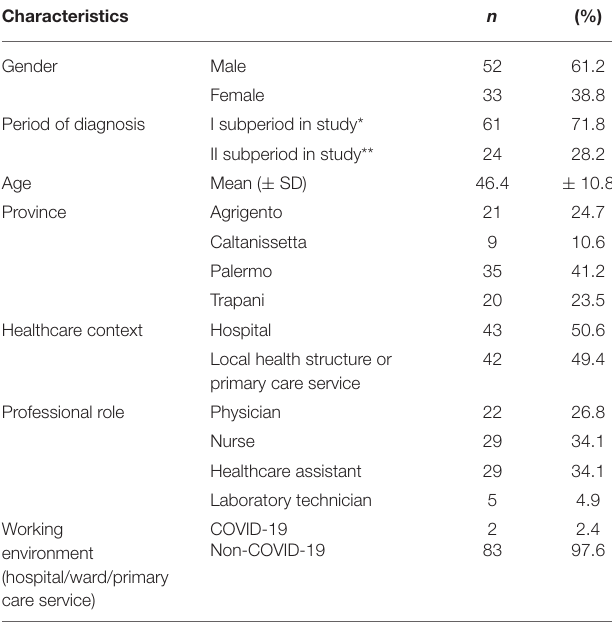
TABLE 1 | Distribution of laboratory-confirmed diagnosis of SARS-CoV-2 infections among HCWs and the general population. Location